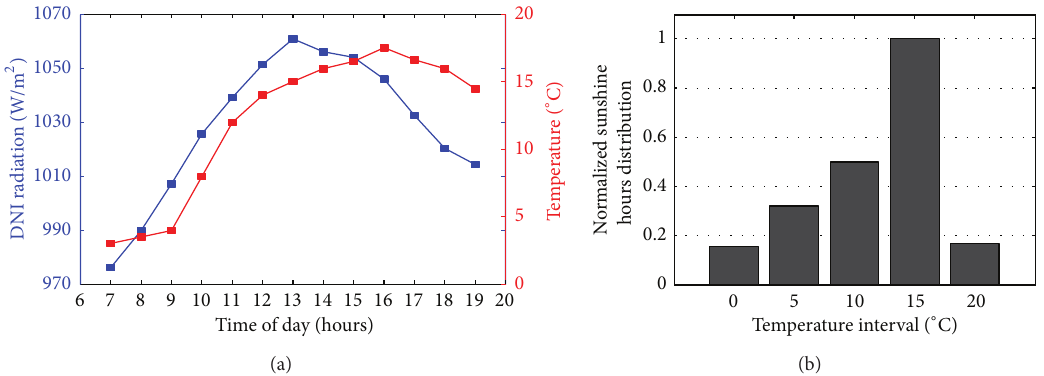
Figure 9: (a) The variation of solar DNI radiation as ambient temperature. (b) The corrected sunshine hours distribution of temperature interval 13th of June in 2006 (Waliguan in Qinghai).